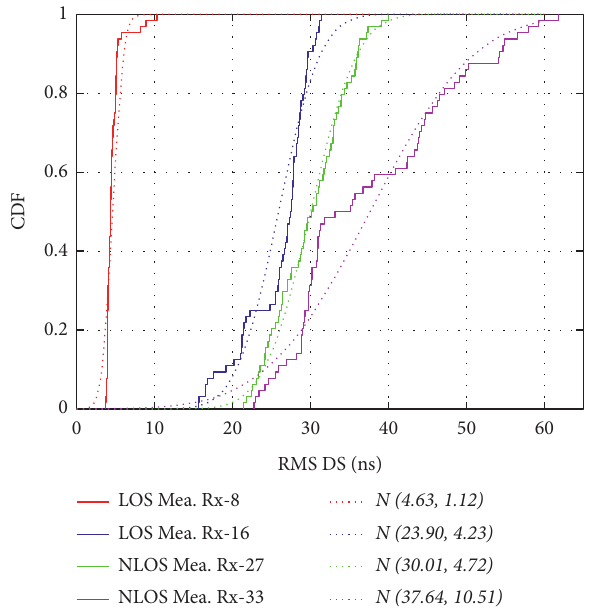
Figure 7: RMS delay spread in LOS and NLOS